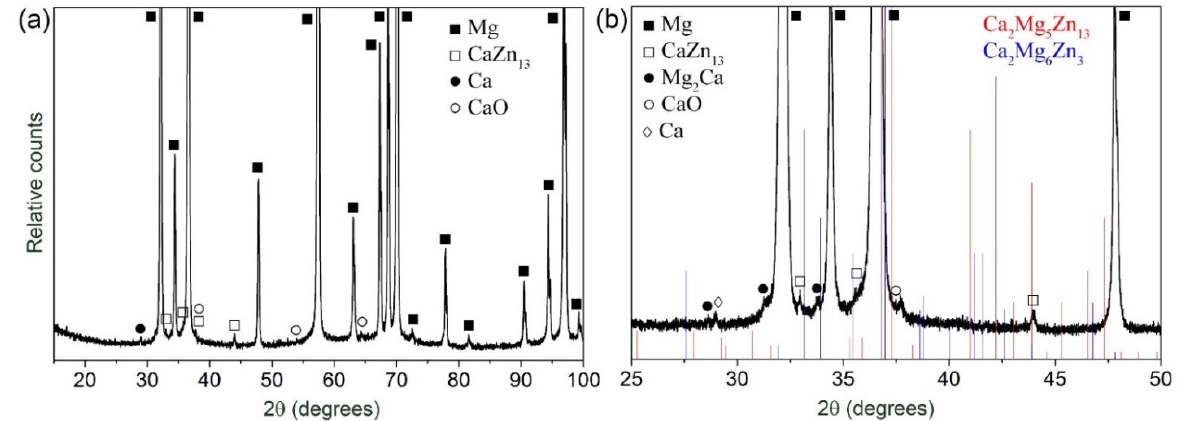
Figure 4. The X-ray diffraction pattern of the as-fabricated Mg-1Zn-0.2Ca alloy: ( a ) full scan, ( b ) fragment of the XRD pattern obtained at a slower scan speed of 0.1 deg/min with a scan step of 0.005 deg.